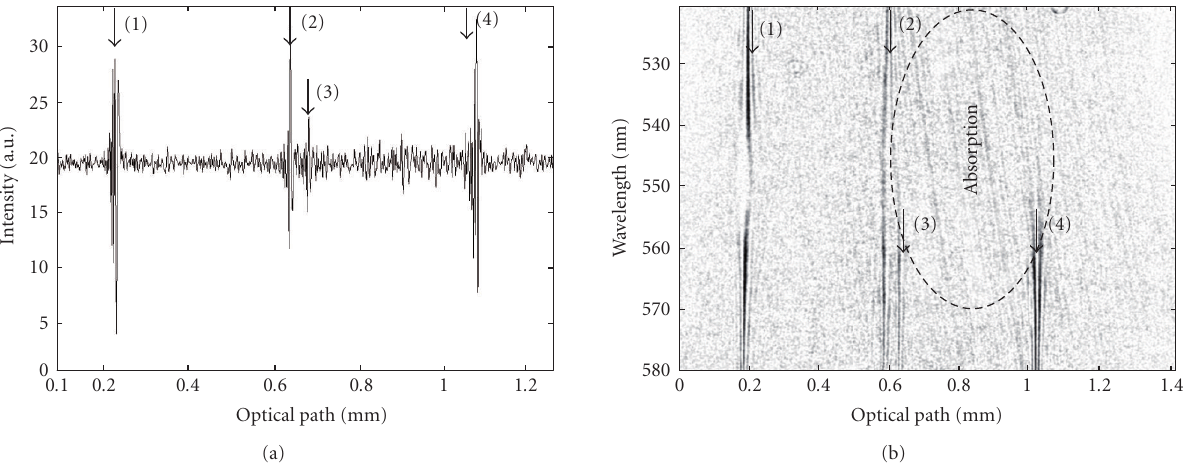
Figure 5: Experimental OCT signals obtained on an eosine solution layer sandwiched by capillarity between two microscope cover slides. (a) Classical “A-scan” obtained with our system (without scanning), (b) instantaneous spectrotomographic signal with visible depth-resolved spectral absorption of the eosine